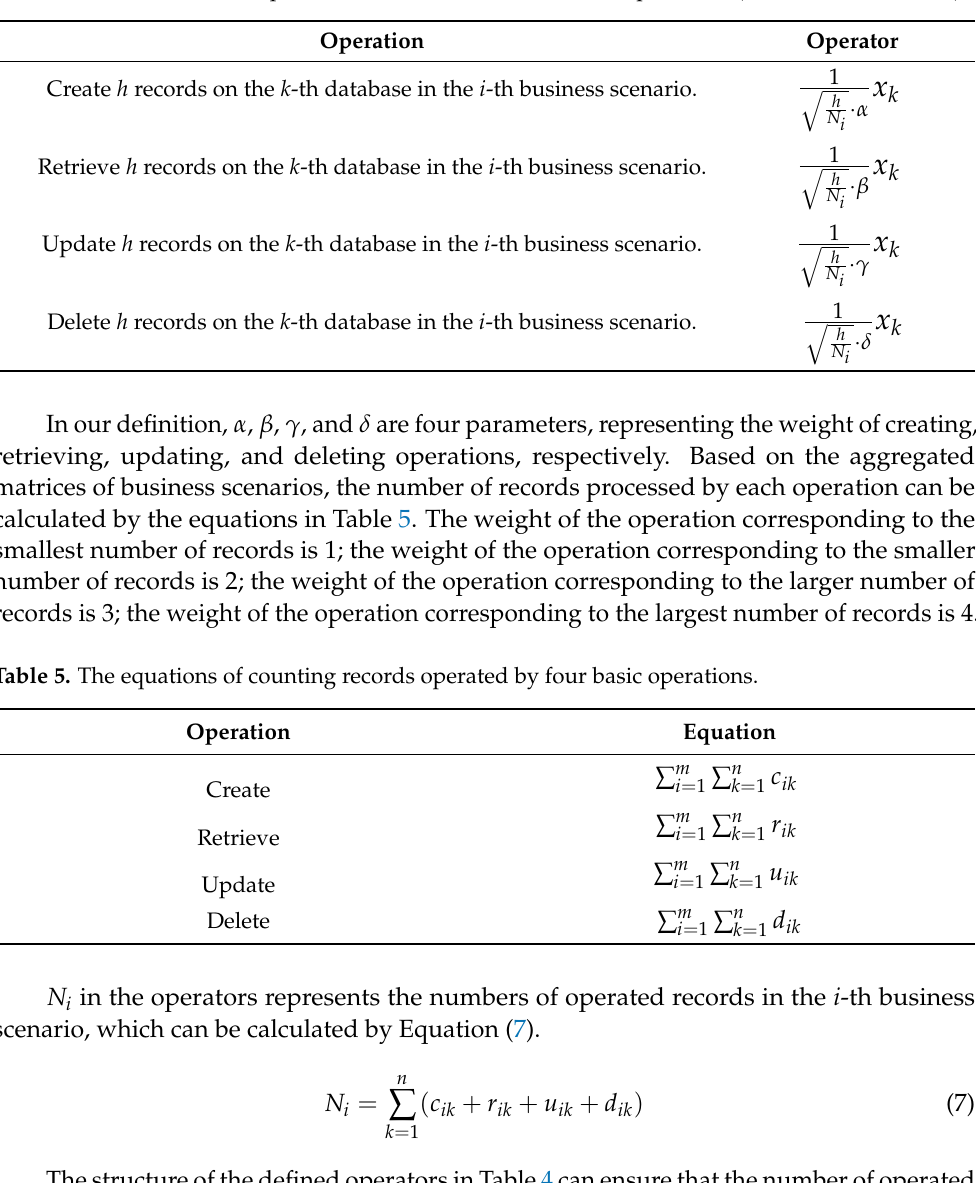
Operation Operator